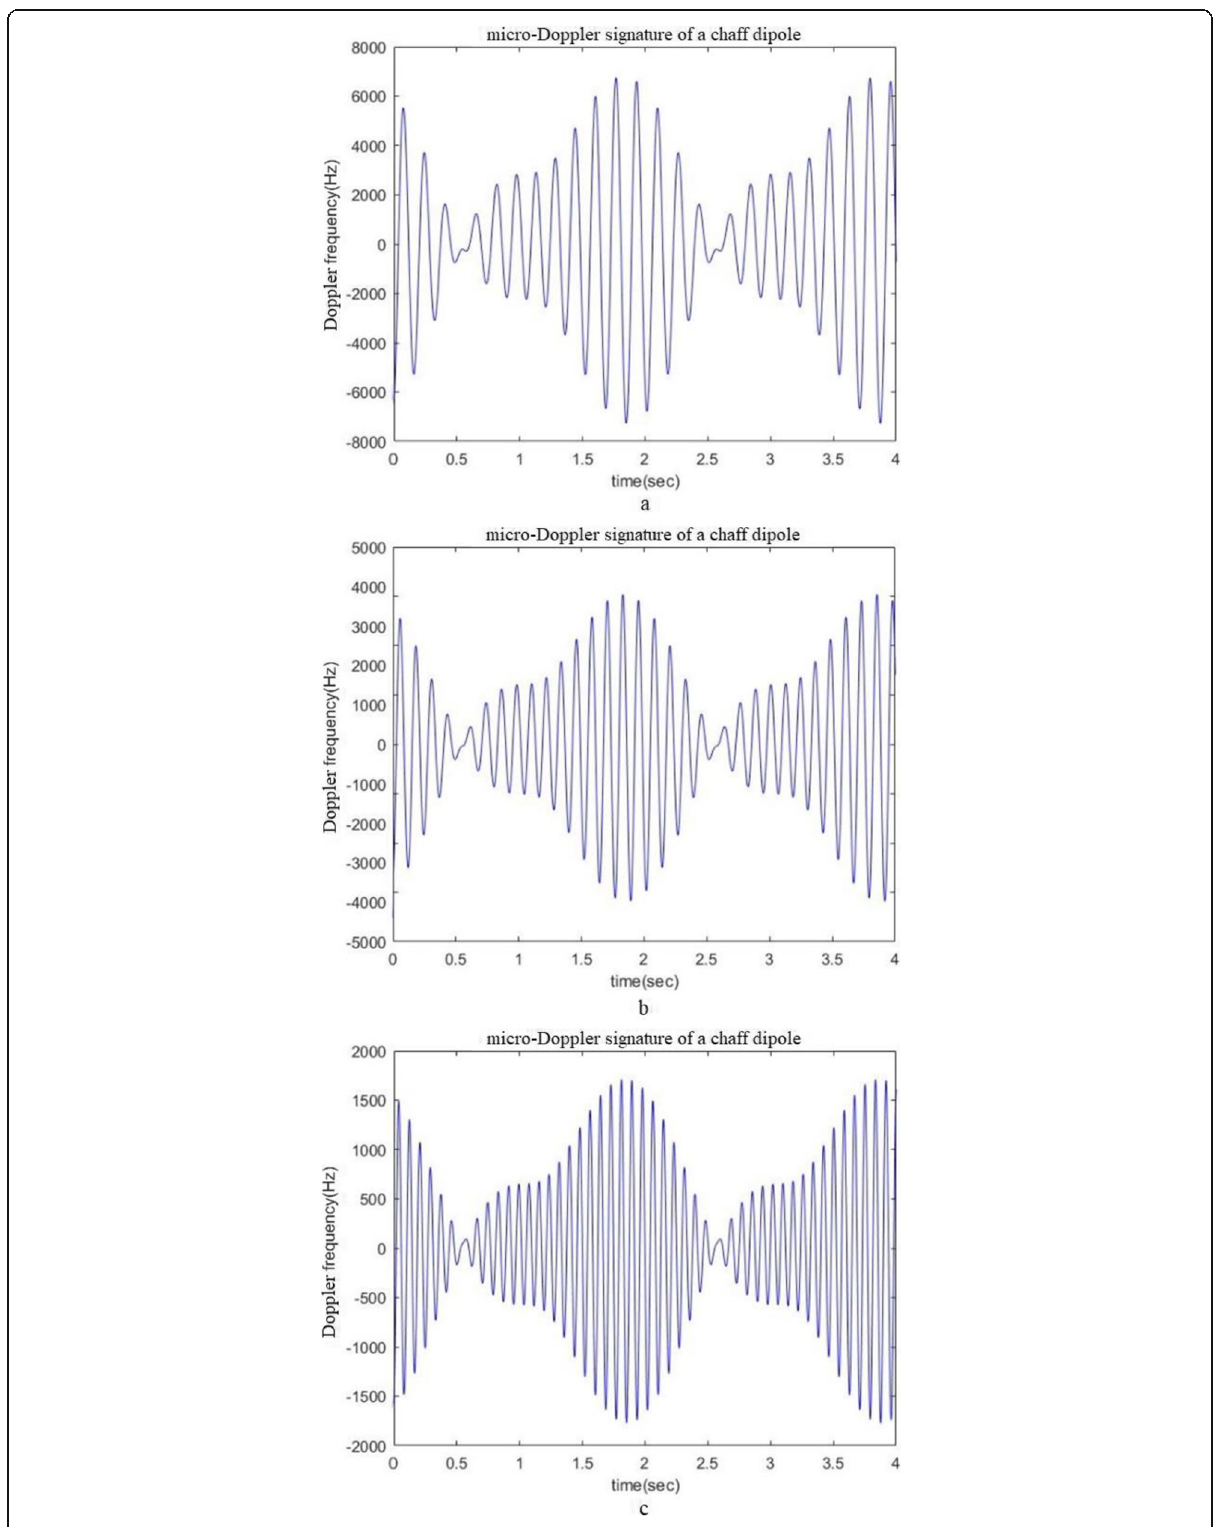
Fig. 7 Micro-Doppler frequency of single chaff dipoles with different ranges (in the radar coordinate system): a θ = 30 ∘ , φ = 30 ∘ , d r = 706 m , b θ = 30 ∘ , φ = 30 ∘ , d r = 709 m , and c θ = 30 ∘ , φ = 30 ∘ , d r = 716